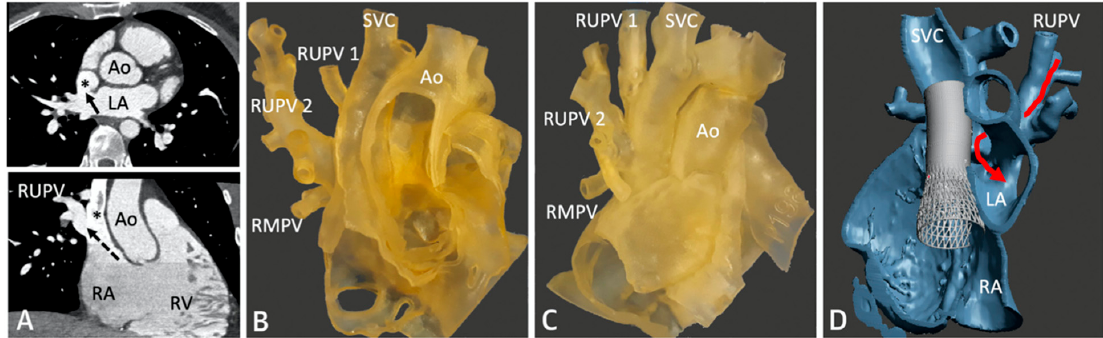
Figure 2. Series of images depicting pre-procedural planning with CT ( A ), three-dimensional (3D) printed models ( B , C ), and 3D virtual modeling ( D ). The defect is represented by an asterisk (*) in ( A ). After review with 3D imaging, each patient was either referred for covered stent placement ( B , D ) or surgical repair ( C ), if deemed inappropriate for percutaneous closure. Revised from ref [4].